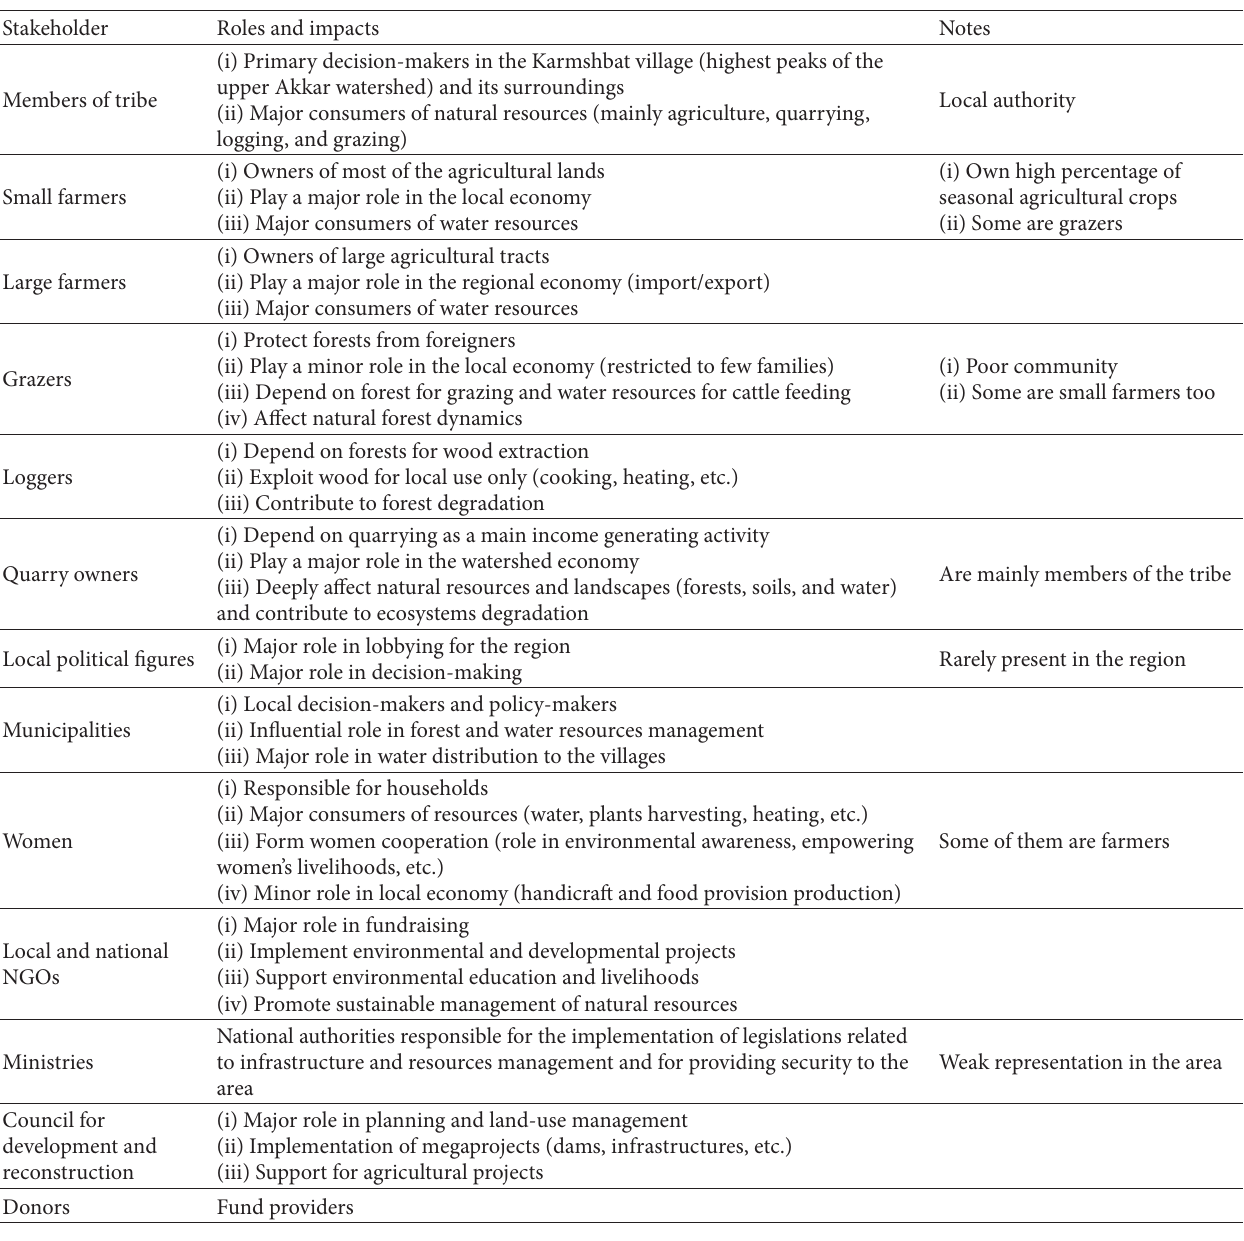
Table 1: Analysis of primary stakeholders’ roles and impacts on the socioeconomic and environmental levels in the upper Akkar watershed. Stakeholder